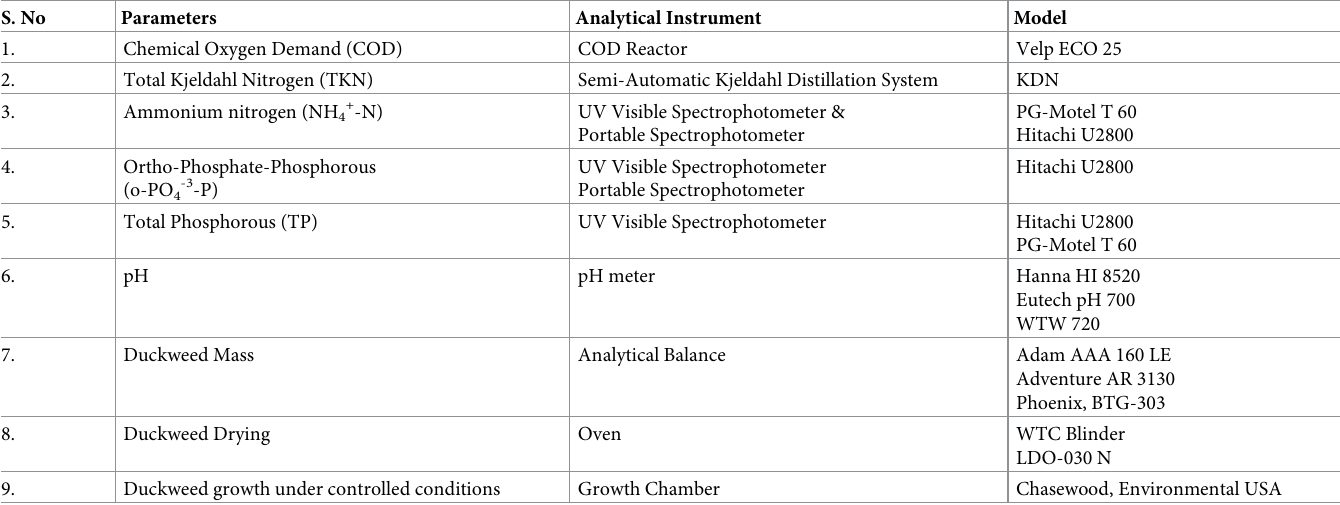
Table 3. Analytical instruments and apparatus used during the study.